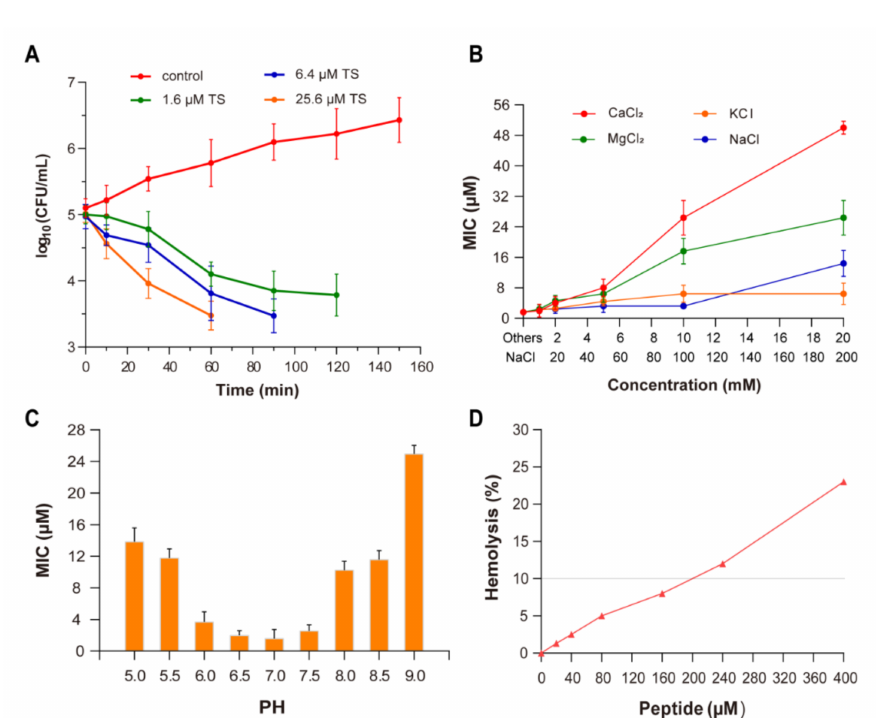
Figure 2. Antibacterial activity and physicochemical properties of antimicrobial peptide TS. ( A ) Time killing curve for E. coli ATCC 25922 in a MH broth with antimicrobial peptide TS (control, no antibiotic). ( B ) The effect of the ions Ca 2+ , Mg 2+ , K + , and Na + , on the antimicrobial activity of TS against E. coli ATCC 25922. ( C ) The effect of pH on the antimicrobial activity of TS against E. coli ATCC 25922. ( D ) The hemolytic activity of antimicrobial peptide